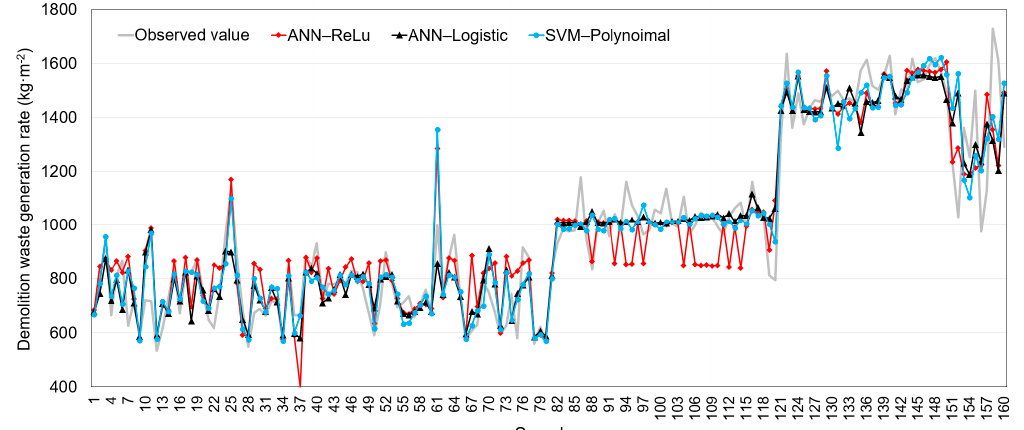
Figure 5. Comparison of observed and predicted values by ANN − ReLu, SVM − polynomial, and ANN − Logistic.